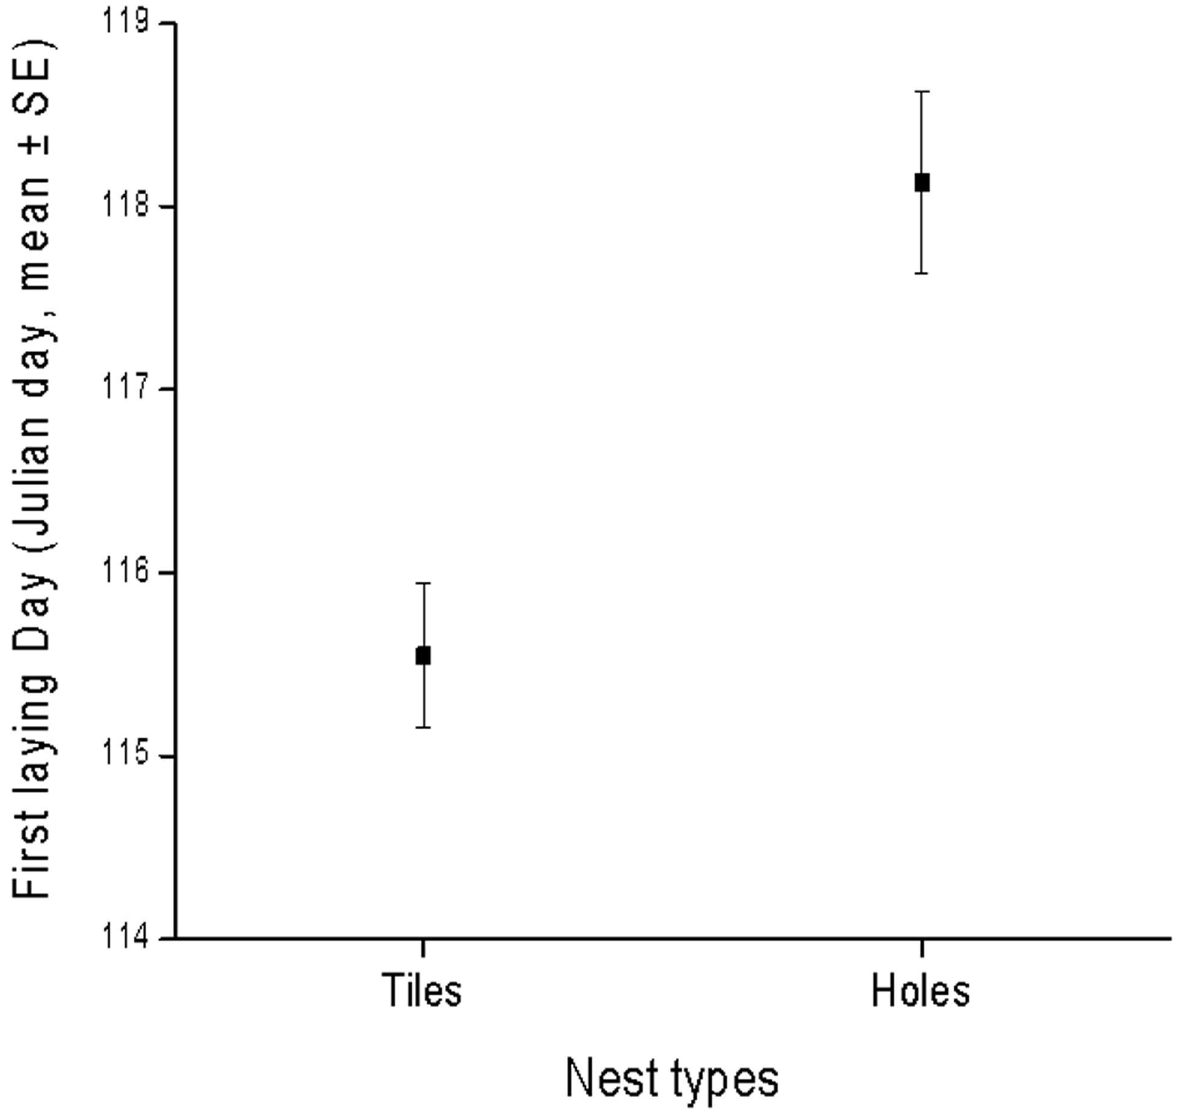
Fig 2. Nesting onset as expressedby the first laying day of 837 kestrelpairs nesting in 16 colonies during nine breeding seasons (2004-2013, with the exception of